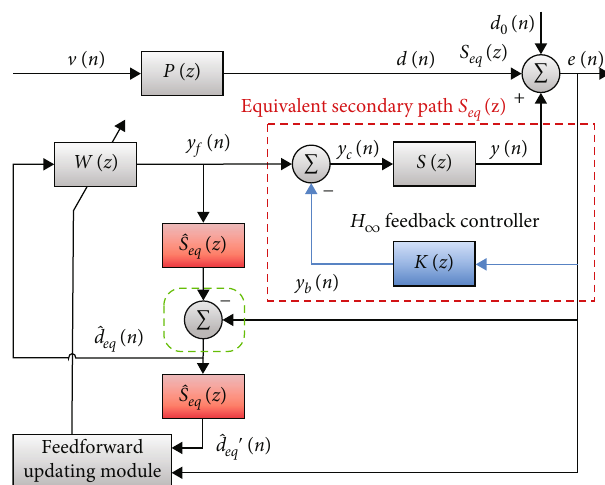
Figure 1: Block diagram of the previous LMS-MSRC algorithm for helicopter ACSR. The red box describes the equivalent secondary path, and the green one shows reference signal